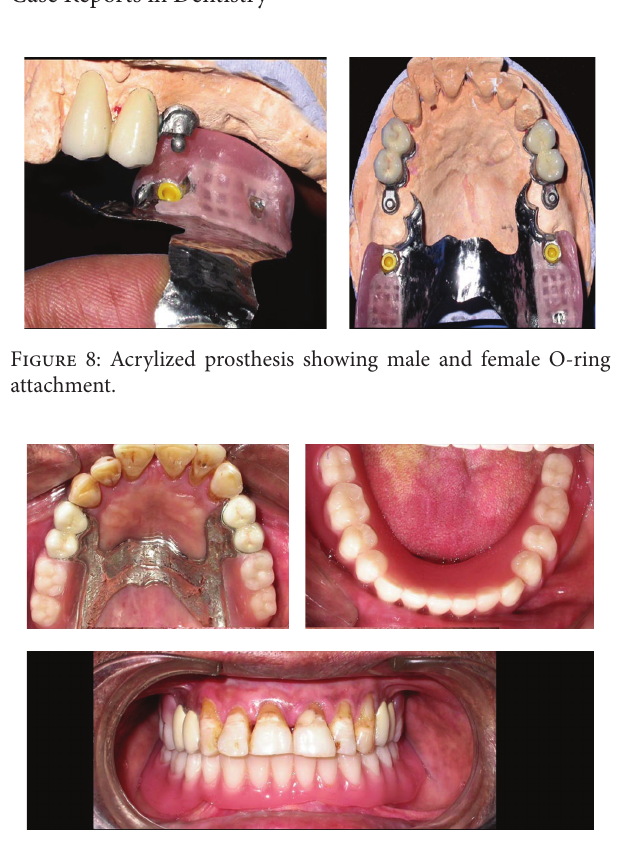
Figure 9: Postinsertion photo with combined prosthesis seated.